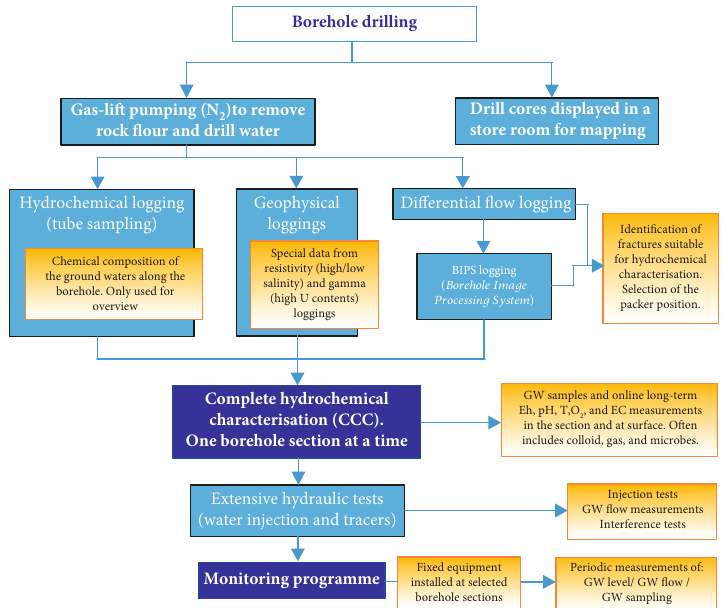
Figure 1: Schematic overview of a general investigation sequence in a telescopic core-drilled borehole designed for chemical characterisation. The most important hydrochemical sampling methods (Complete Chemical Characterisation, i.e., CCC, and monitoring) are shown in boxes with a darker blue colour and text in bold. GW: groundwaters; Eh: redox potential; T: temperature; EC: electrical conductivity. A more detailed description can be found in Supplementary Material